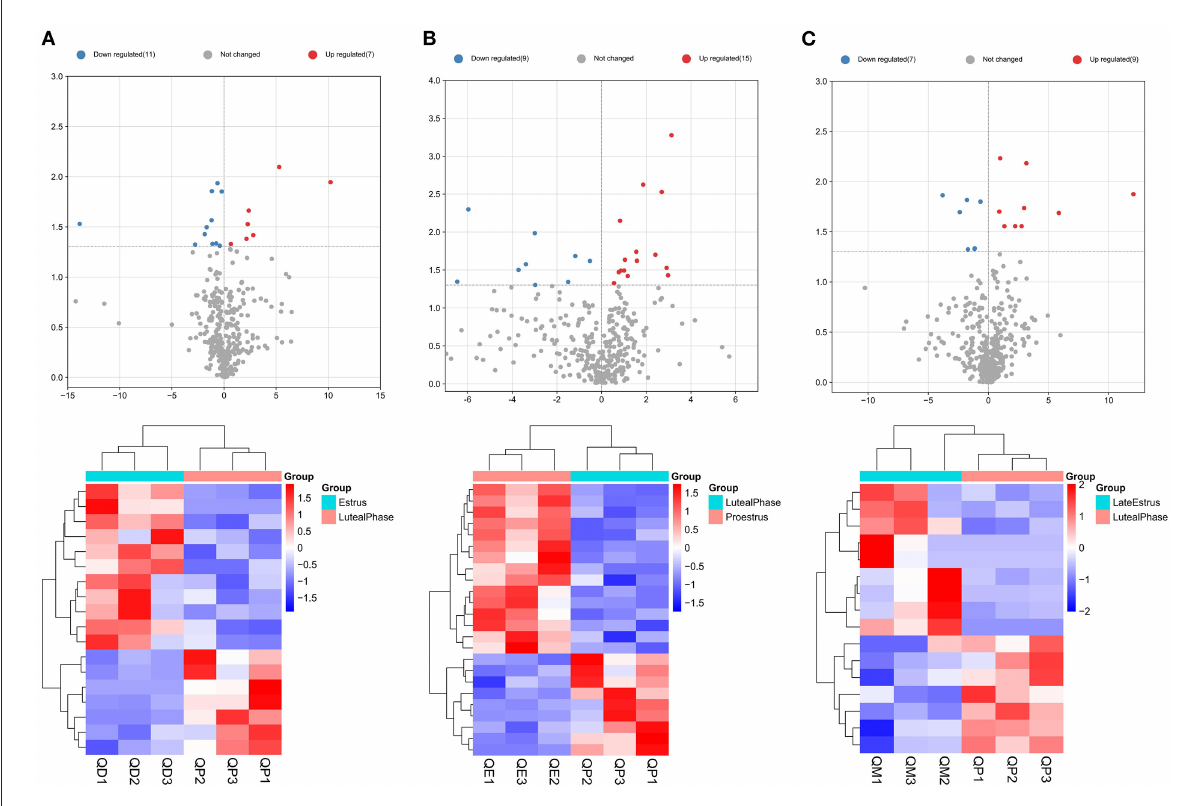
FIGURE2 Graphical representation of DELncRNAs at each stage of the estrous cycle in sheep. The Volcano map and Hierarchical clustering analysis of DELncRNAs in the QD-QP (A) , QE-QP (B) , and QM-QP (C) .